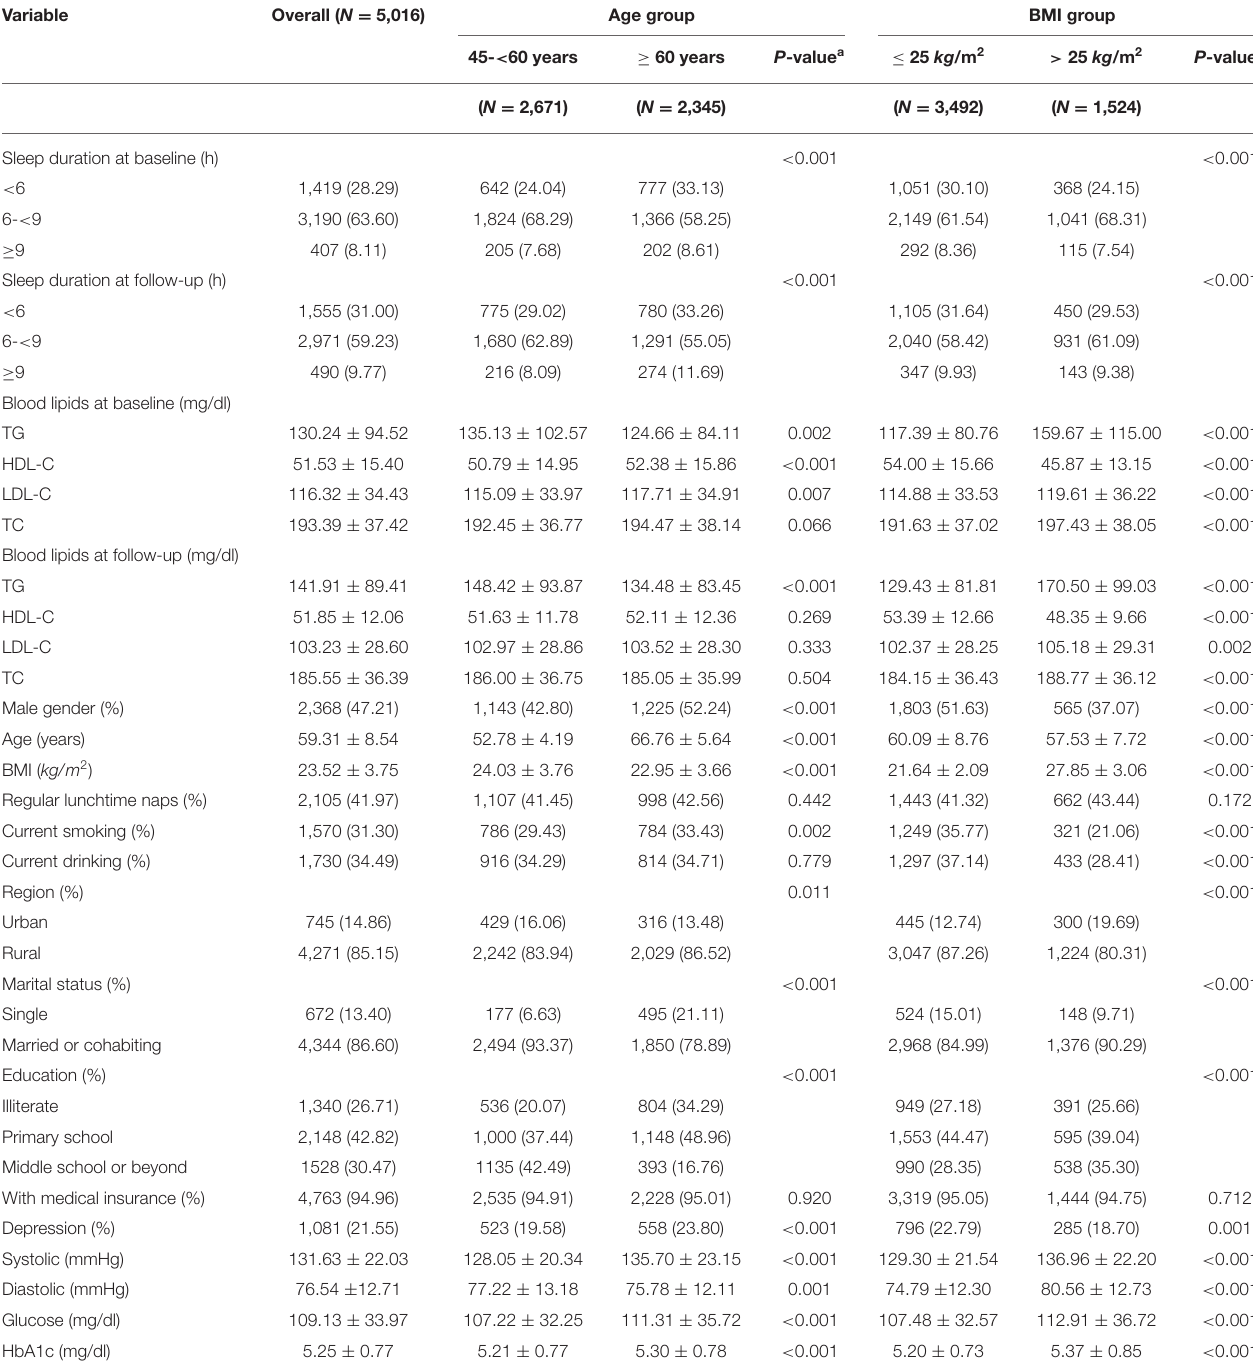
Values are mean ± SD or n (percentage). TG, Triglycerides; HDL-C, High-density lipoprotein cholesterol; LDL-C, Low-density lipoprotein cholesterol; TC, Total cholesterol; BMI, Body mass index. a P-values for differences between age categories. b P-values for differences between BMI